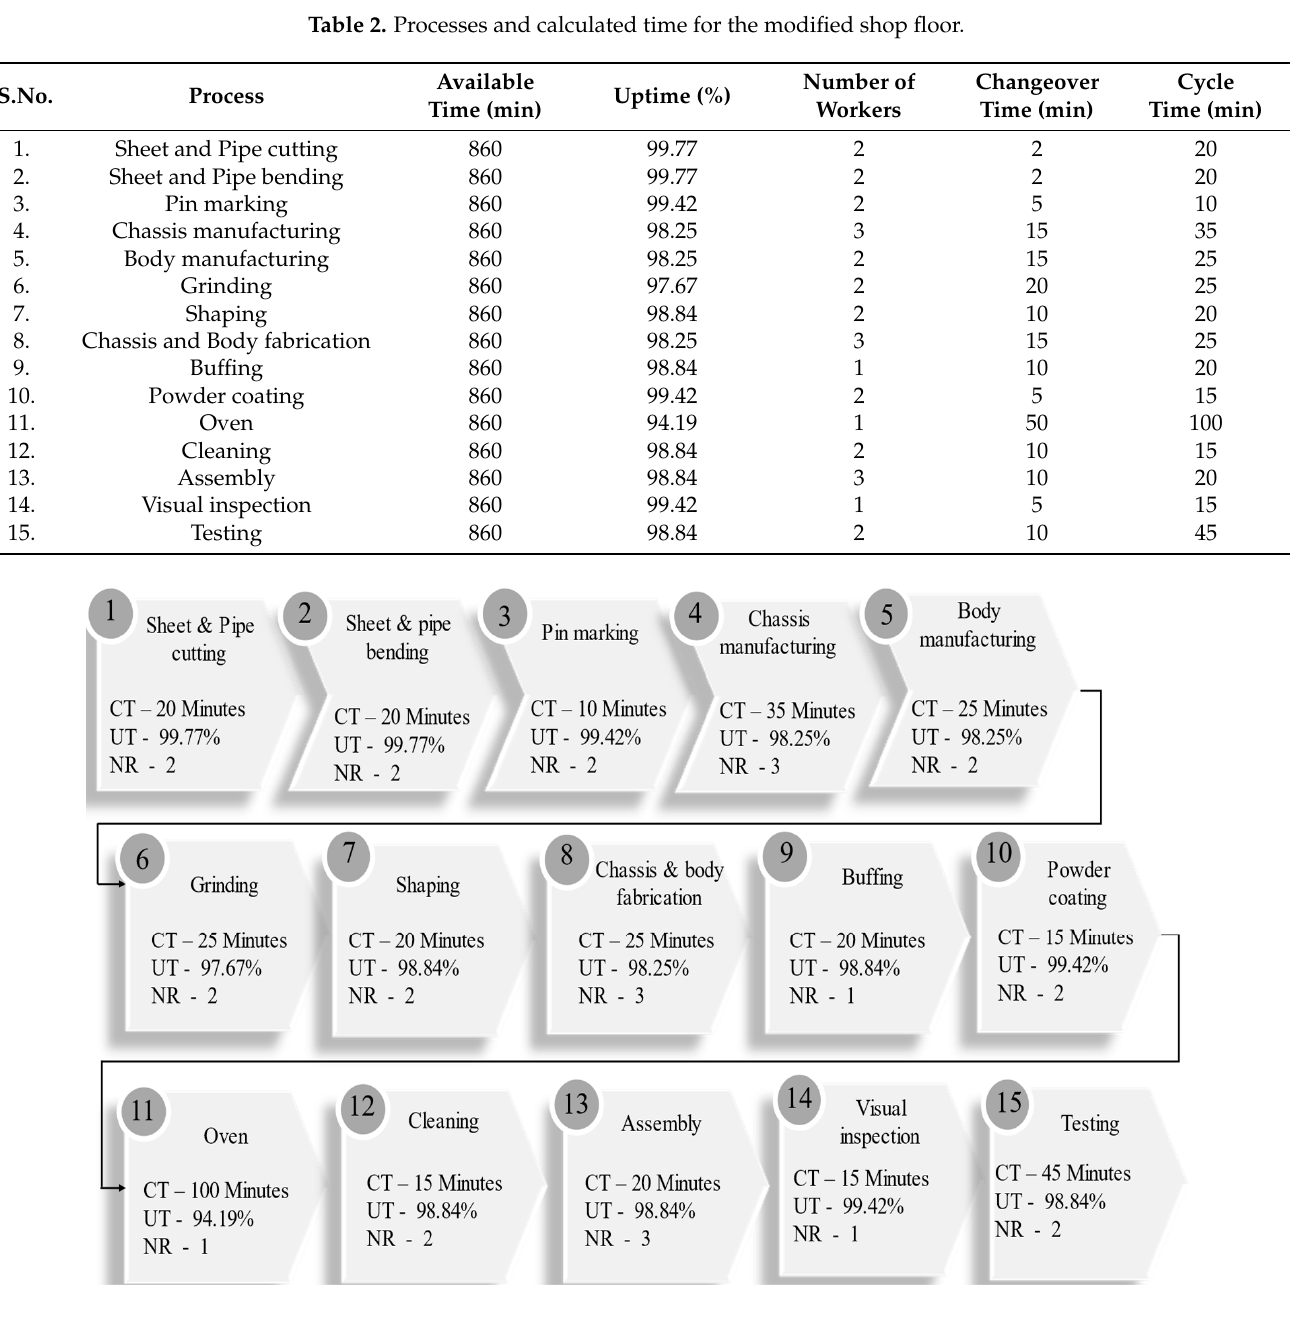
Figure 8. Modified workflow for the proposed shop floor.